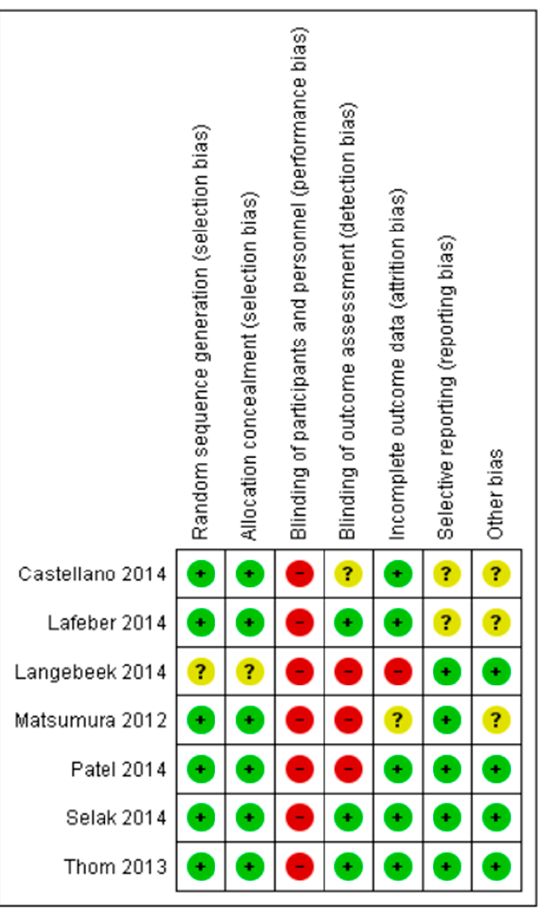
Figure 3. Results of risk of bias assessment for all randomized controlled trials (RCTs). Green: low risk of bias; red: high risk of bias; yellow: unclear risk of bias.